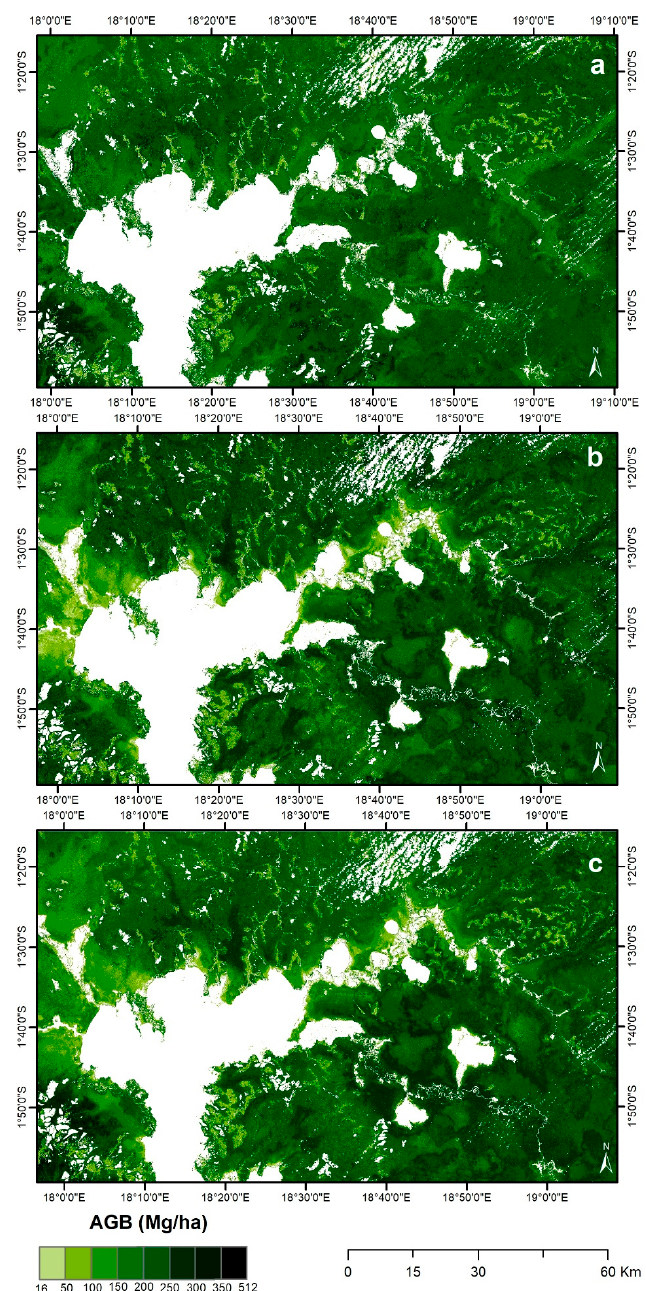
Figure 6. Estimated 30 m aboveground biomass (AGB) derived from the 30 m predicted dominant forest canopy height maps (Figure 4) generated using ( a ) the dry season July 14th 2013 Landsat-8 OLI image, ( b ) the wet season December 8th 2014 Landsat-8 OLI image, and ( c ) both images.